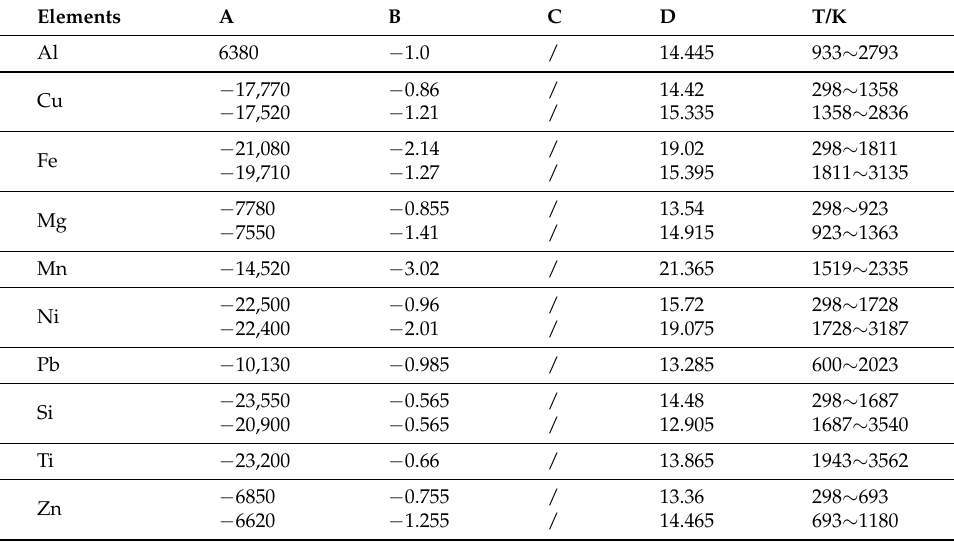
Table 5. The saturation vapor pressure constants of some elements at given temperatures, data from